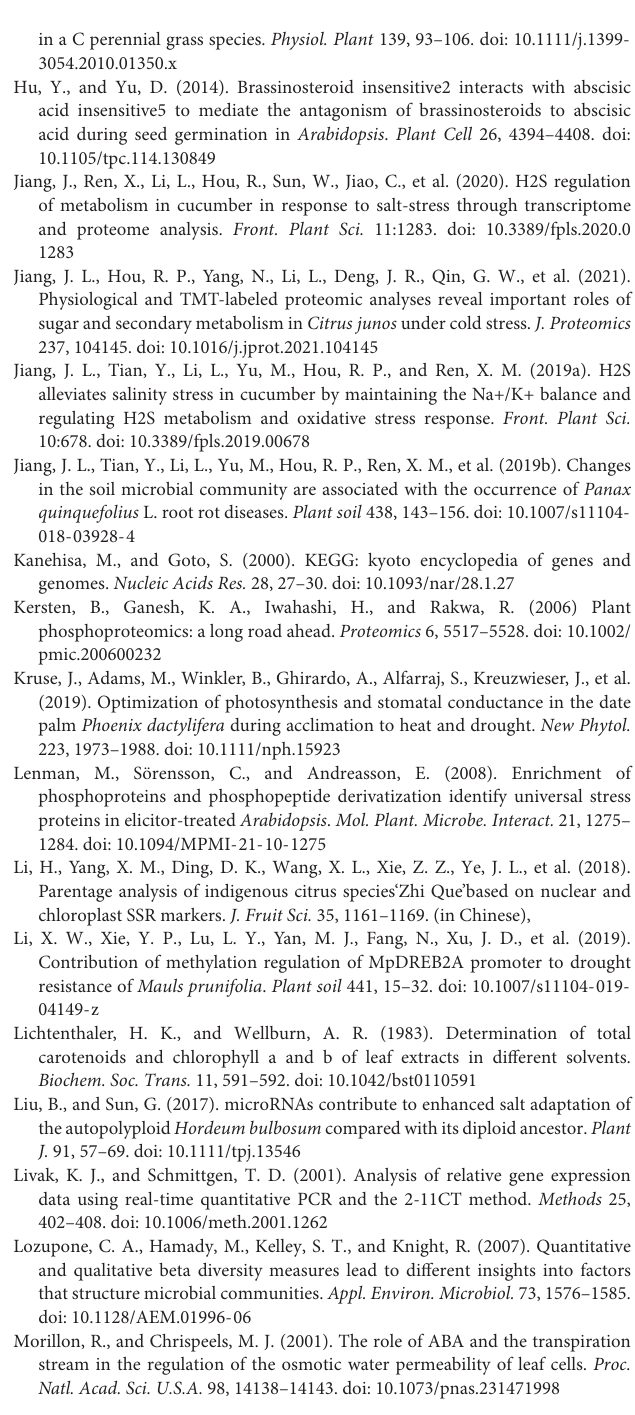
Supplementary Table 6 | Summary of RNA-seq data for each sample. Supplementary Table 7 | Summary of alignment rates to the reference genome for each sample. Supplementary Table 8 | DEGs in the leaves from the two samples comparison (DD vs